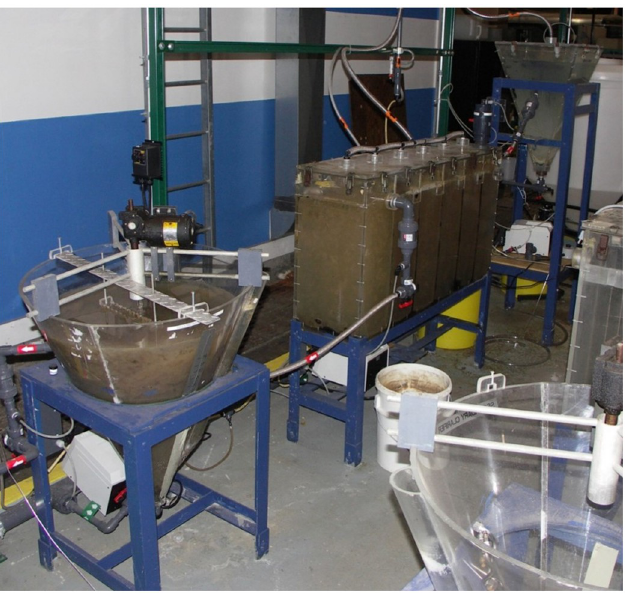
Fig 1. Photograph of the pilot-scale AST system. Right/rear: Primary clarifier; middle: aeration basin; left/front: secondary clarifier.